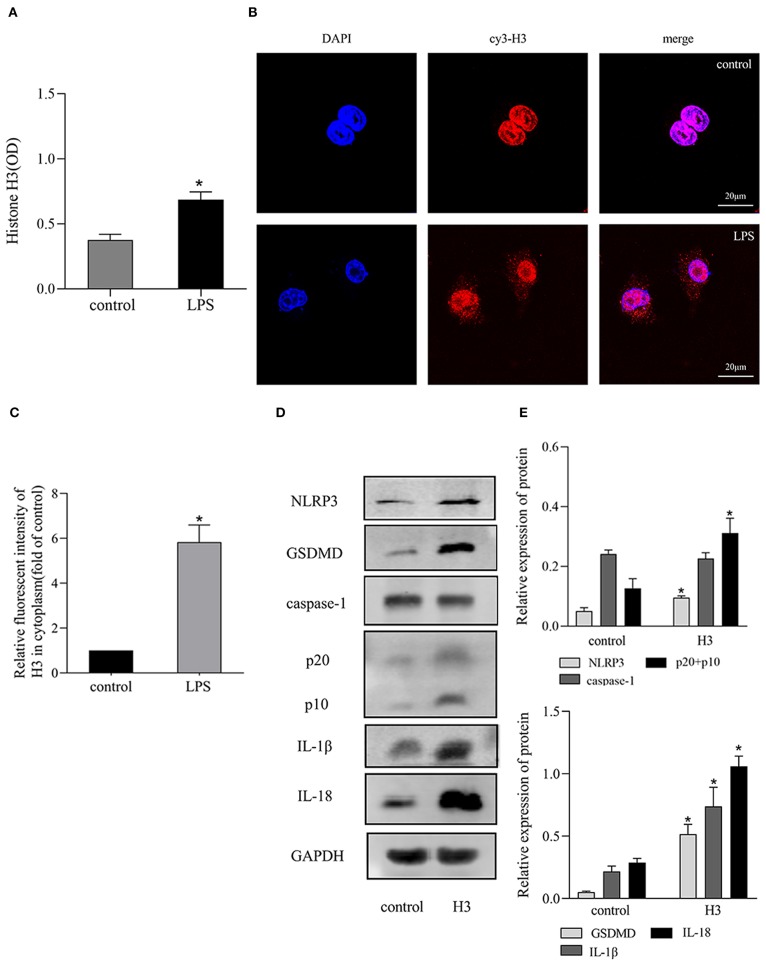
LPS stimulated the release of histone H3 and H3 induced pyroptosis in vitro. Cells were stimulated with LPS (10 μg/ml) for 24h or histone H3 (50 μg/ml) for 12 h. (A) ELISA results of histone H3 in cell supernatant. (B,C) Immunofluorescence was used to detect the expression of histone H3 in cytoplasm. Relative fluorescent intensity of histone H3 in cytoplasm was presented as mean ± SDs of three independent experiments. (D,E) Effects of histone H3 on NLRP3, caspase-1, GSDMD, IL-1β, IL-18 protein levels in ANA-1 cells. Odyssey was used to calculate the grayscale of each strip and the results (relative expression to GAPDH) were presented as mean ± SDs based on three repetitions. *P < 0.05, compared with control group.